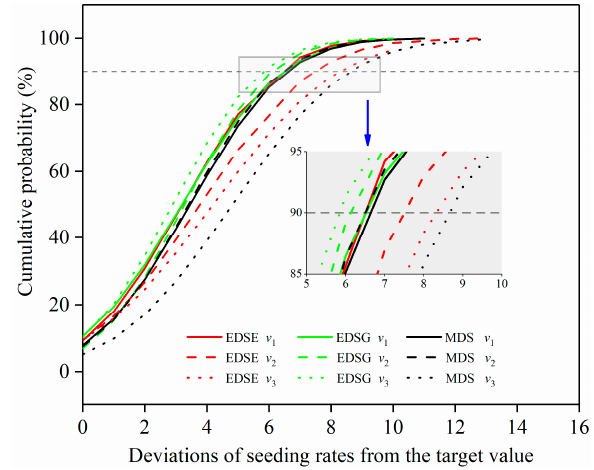
Figure 7. The cumulative probability functions of deviation of seeding rates against confidence in- tervals with MDS, EDSE, and EDSG, for the three different operational speeds.